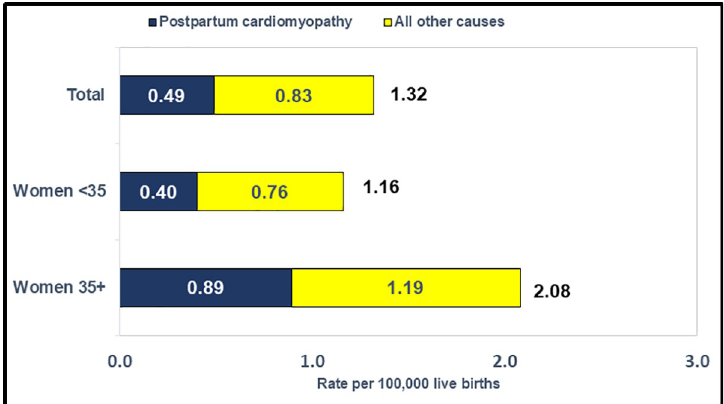
Fig 3. Late maternal mortality rates for postpartum cardiomyopathy and all other causes by maternal age, United States, 2016–2017.